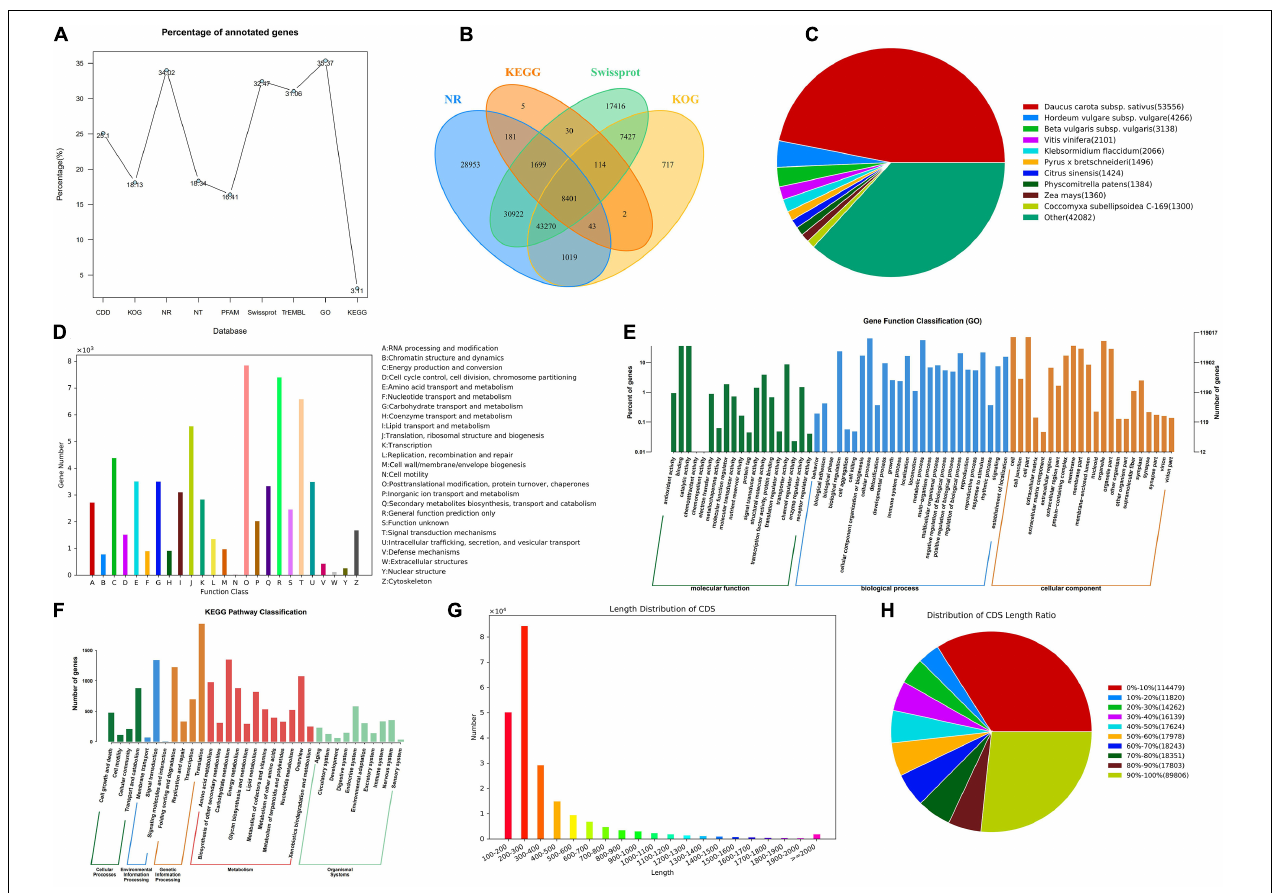
FIGURE 2 | The gene function annotation and the CDS prediction. (A) The ratio line chart of the main database annotation. (B) The Venn map of the annotated genes based on NR, Kyoto Encyclopedia of Genes and Genomes (KEGG), Swissprot, and KOG. (C) The distribution of homologous species based on NR. (D) The classification of annotation function based on KOG. (E) The Gene Ontology (GO) annotation distribution of different categories. (F) The KEGG pathway classification of the annotated genes. (G) The length distribution of CDS. (H) Distribution of CDS length